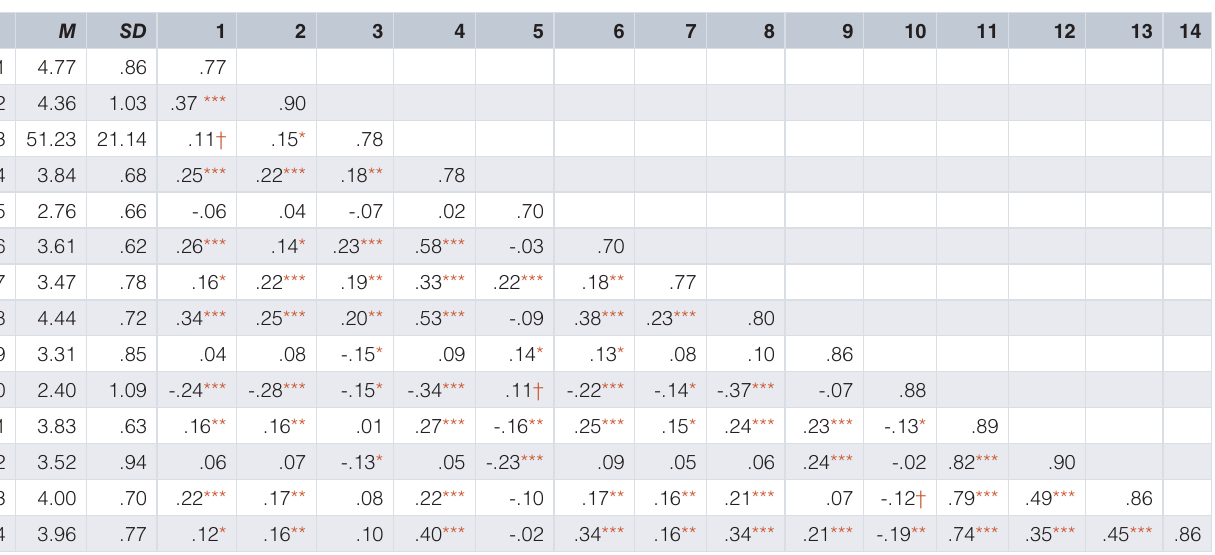
Table 3. Descriptive statistics, Cronbach’s α , and correlation test